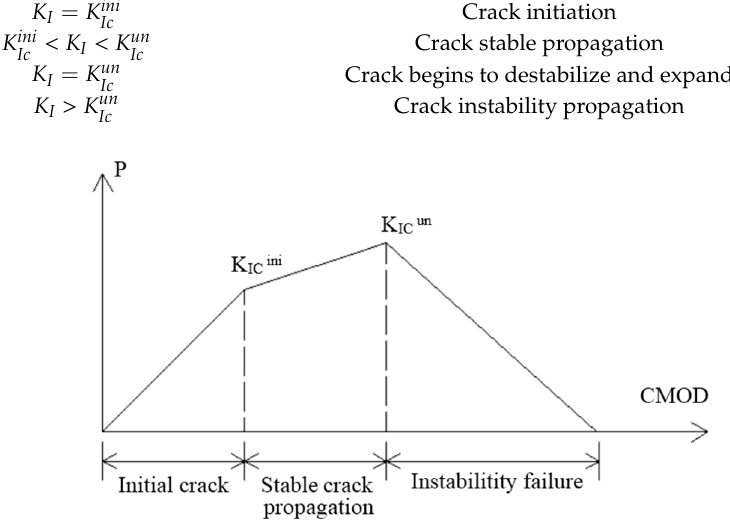
Figure 9. P-CMOD curve of concrete.